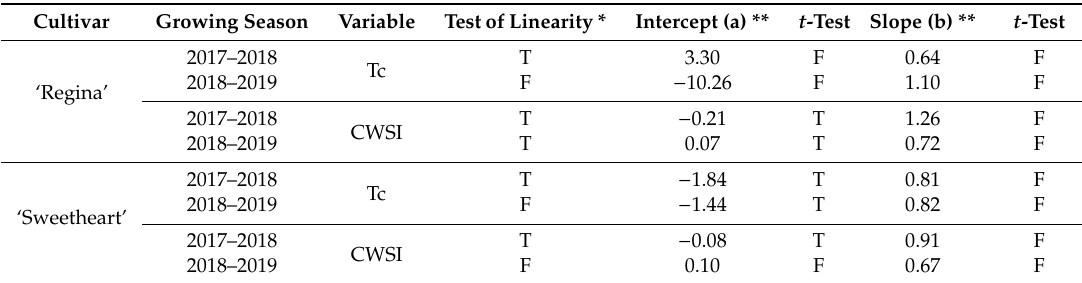
Table 1. Statistical analysis of the comparisons between all data of canopy temperature (Tc) and crop water stress index (CWSI), computed from thermal images of high (HR) vs. low (LR) resolution, for ‘Regina’ and ‘Sweetheart’ cherry trees considering all irrigation